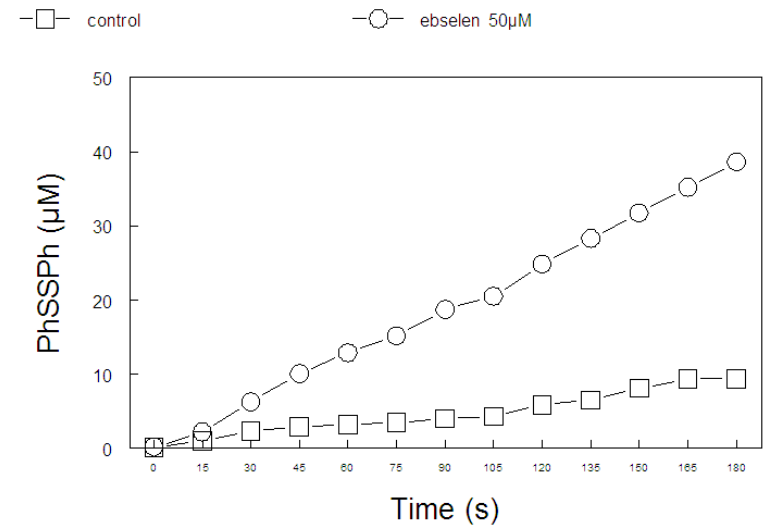
Figure 5. GPx like behavior of ebselen . Fifty µM of ebselen was tested. Statistical analysis were performed by two-way ANOVA (two concentrations × 13 times of sampling). Data analysis yielded a significant concentration × sampling time interaction [F(12,144) = 228,4; p < 0.000001], which indicates that ebselen caused an increase in PhSSPh formation